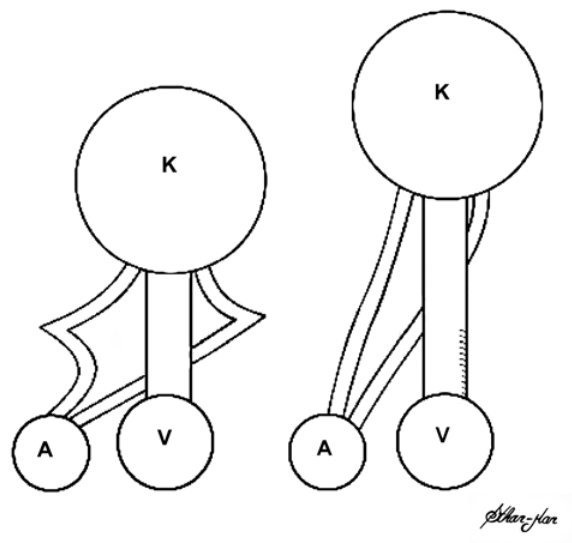
Figure 4 – Schematic drawings demonstrating that elonga- tion of the right renal vein avoids kinking of the renal arter- ies. A = iliac artery of the recipient, V = iliac vein of the recipi- ent, K =